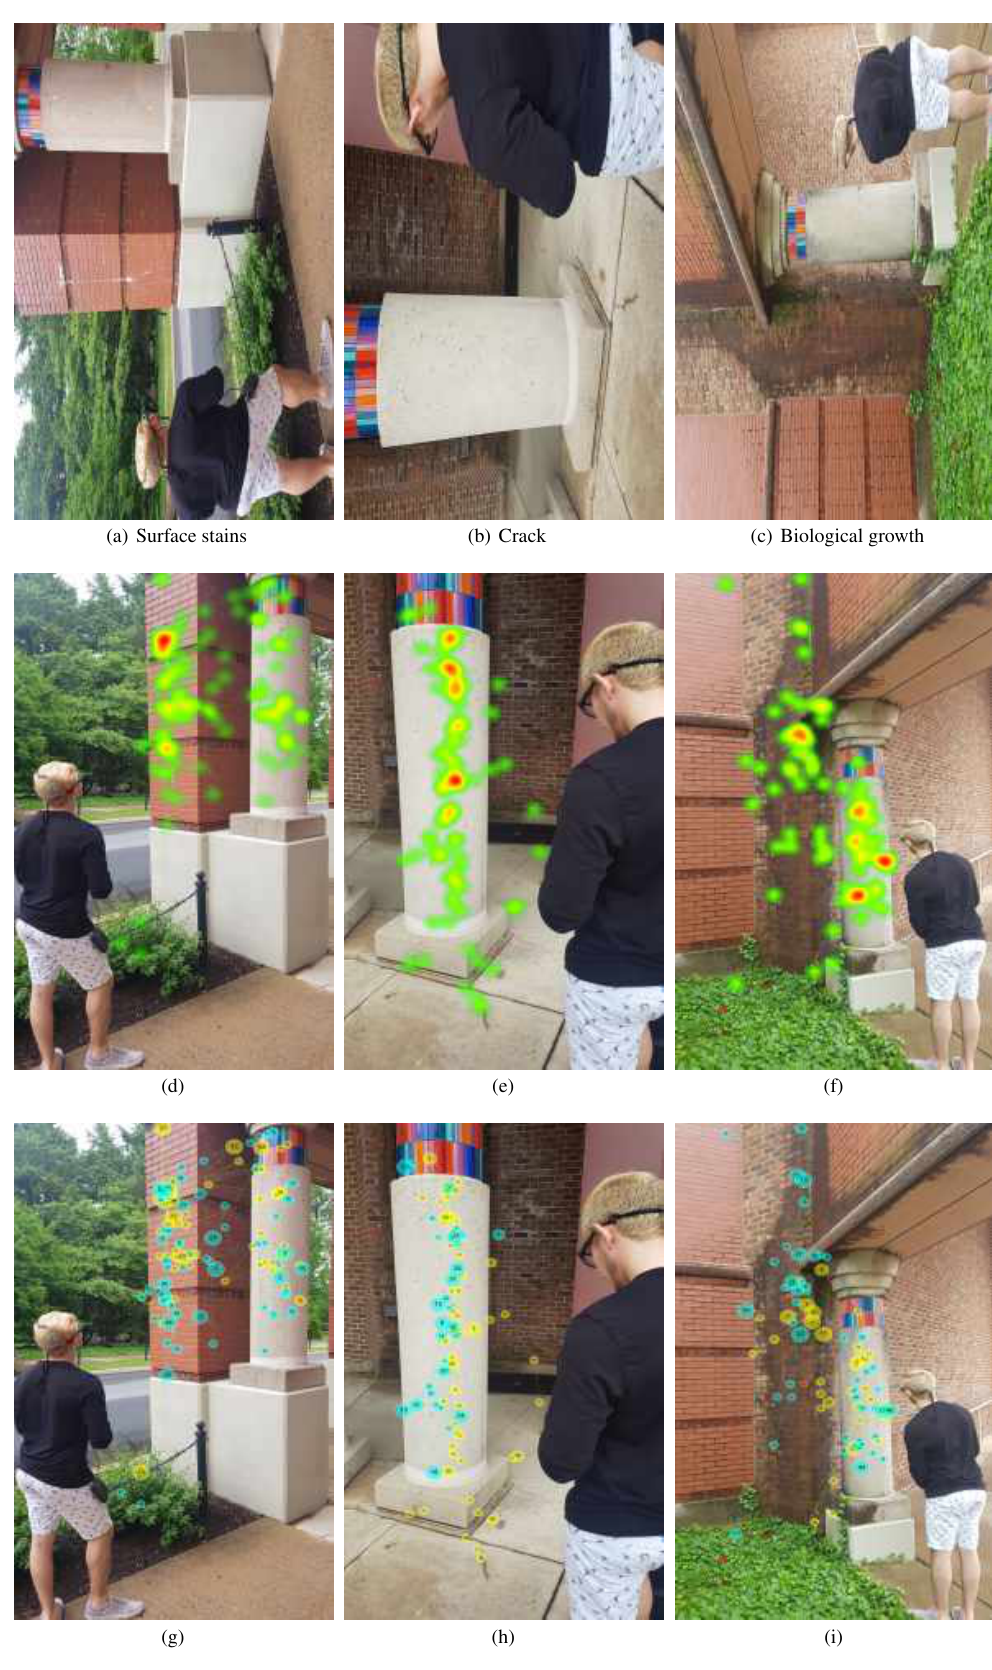
Figure 4. Heatmaps and gaze plots for different sections of building structure; (a-c): Original images; (d-f): Aggregated heatmaps; (g-i): Aggregated gaze plots—’Yellow’ indicates participant-1 and ’Cyan’ indicates